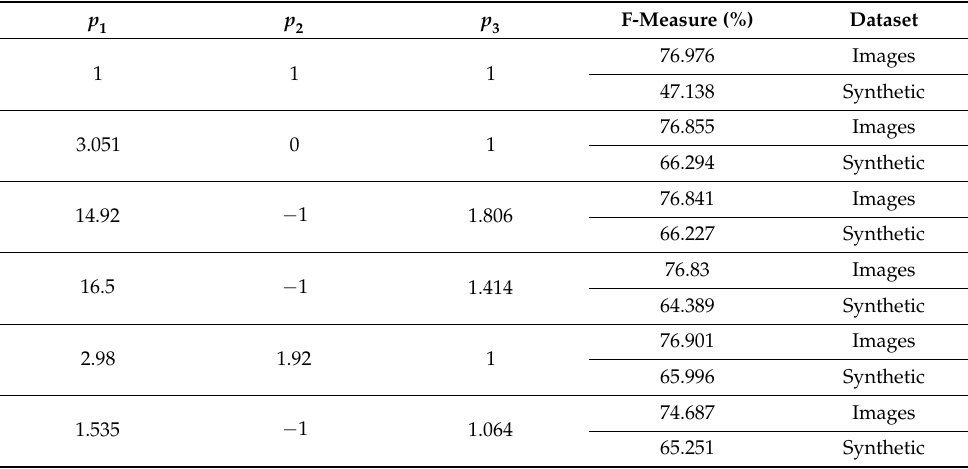
Table 4. Mean values for F-measures for different power